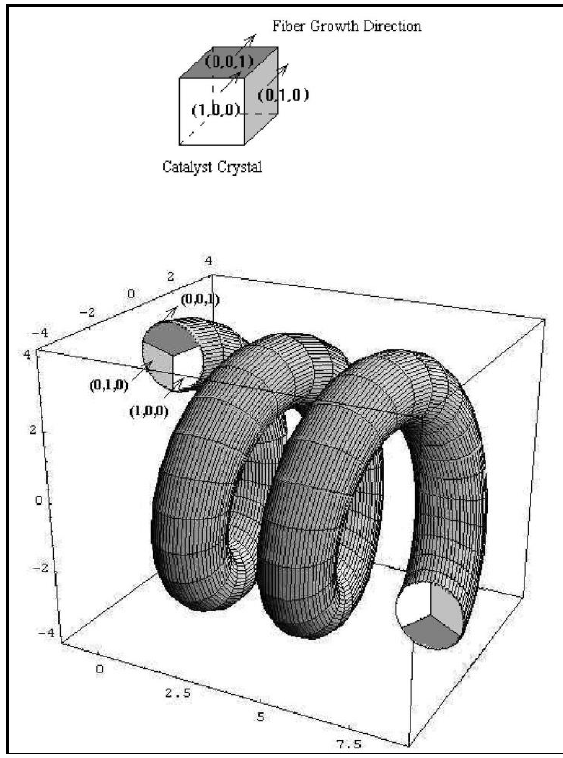
Figure 11. 3D model for thegrowth mechanism of coiled carbon nanofibers ([59], Wen and Shen,